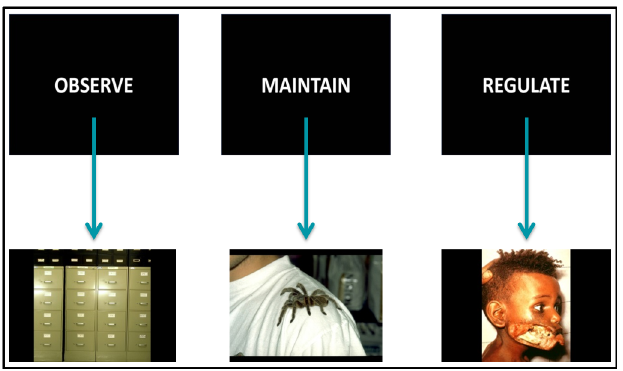
Fig 1. fMRI task. Example images for Observe, Maintain and Regulate